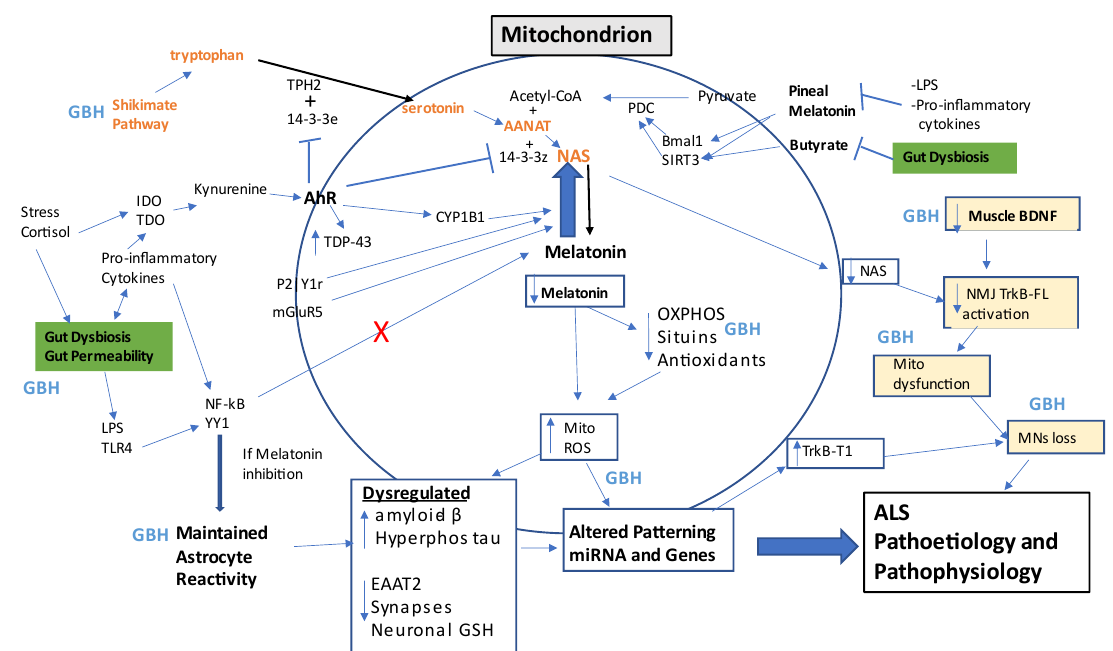
Figure 2. This summary figure shows how many ALS-linked factors can impact mitochondrial function, with relevance across different cell types. Gut dysbiosis is highlighted in green, whilst muscle-NMJ-MNs loss is highlighted in yellow. Gut permeability-associated LPS activates TLR4/NF- kB/YY1 to drive maintained astrocyte activation in the presence of a suppressed melatonergic pathway. The shikimate pathway produces tryptophan (as well as tyrosine and phenylalanine) to drive the serotonin/NAS/melatonin pathway, which requires different 14-3-3 isoforms and acetyl-CoA to be functional. A number of factors can ‘backward’ convert melatonin to NAS, including P2Y1r, mGluR5, and AhR activation. NAS can be beneficial in ALS as it is a BDNF inducer and activator to TrkB-FL. The AhR may also have detrimental effects via 14-3-3 suppression, as well as increasing TDP-43. Gut dysbiosis and pro-inflammatory cytokine suppression of pineal melatonin suppress the capacity of butyrate and melatonin to disinhibit PDC and the PDC conversion of pyruvate to acetyl-CoA, which is a necessary co-substrate of AANAT in the conversion of NAS to melatonin. The suppression of the melatonergic pathway leads to increased oxidants, decreased endogenous antioxidants, OXPHOS, and sirtuins, thereby increasing mitochondrial ROS, ROS-inducing miRNAs, and altered gene patterning, which is a major driver of ALS pathophysiology. The maintained activation of astrocytes decreases neuronal GSH, synapses, and EAAT2 whilst increasing amyloid- β and hyperphosphorylated tau, all of which contribute to ROS-driven changes in patterned miRNAs and gene inductions. The loss of muscle BDNF leads to suboptimal mitochondrial function at the NMJ and MNs loss. All these changes comprise the biological underpinnings of ALS. GBH can have multiple negative impacts, as indicated by points across the figure. Abbreviations: AANAT: aralkylamine N-acetyltransferase; AhR: aryl hydrocarbon receptor; ASMT: N-acetylserotonin O- methyltransferase; BDNF: brain-derived neurotrophic factor; Bmal1: basic helix-loop-helix ARNT Like 1; CYP: cytochrome P450; EAAT: excitatory amino acid transporter; GBH: glyphosate-based herbicides; IDO: indoleamine 2,3-dioxygenase; LPS: lipopolysaccharide; mGluR5: metabotropic glu- tamate receptor 5; mito: mitochondria; MNs: motor neurons; NAS: N-acetylserotonin; NF-kB: nu- clear factor kappa-light-chain-enhancer of activated B cells; NMJ: neuromuscular junction; OXPHOS: oxidative phosphorylation; P2Y1r: purinergic 2Y1 receptor; PDC: pyruvate dehydrogen- ase complex; ROS: reactive oxygen species; SIRT3: sirtuin-3; TDO: tryptophan 2,3-dioxygenase; TDP-43: transactive response DNA binding protein 43kDa; TLR: toll-like receptor; TPH2: trypto- phan hydroxylase; TrkB-FL: tyrosine receptor kinase B-full length; TrkB-T1: tyrosine receptor kinase B-truncated; YYI: yin yang 1.